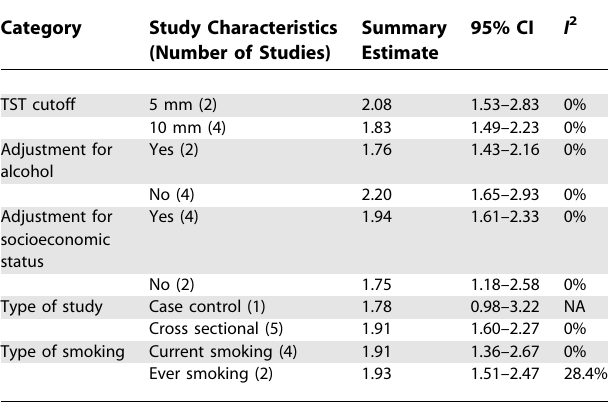
Table 2. Quality Assessment and Subgroup Analysis: